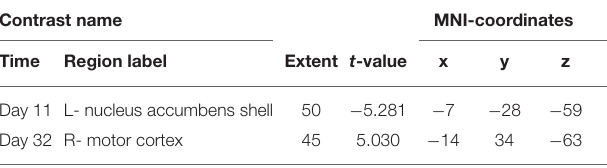
TABLE 2 | Differences in DC values between model and sham